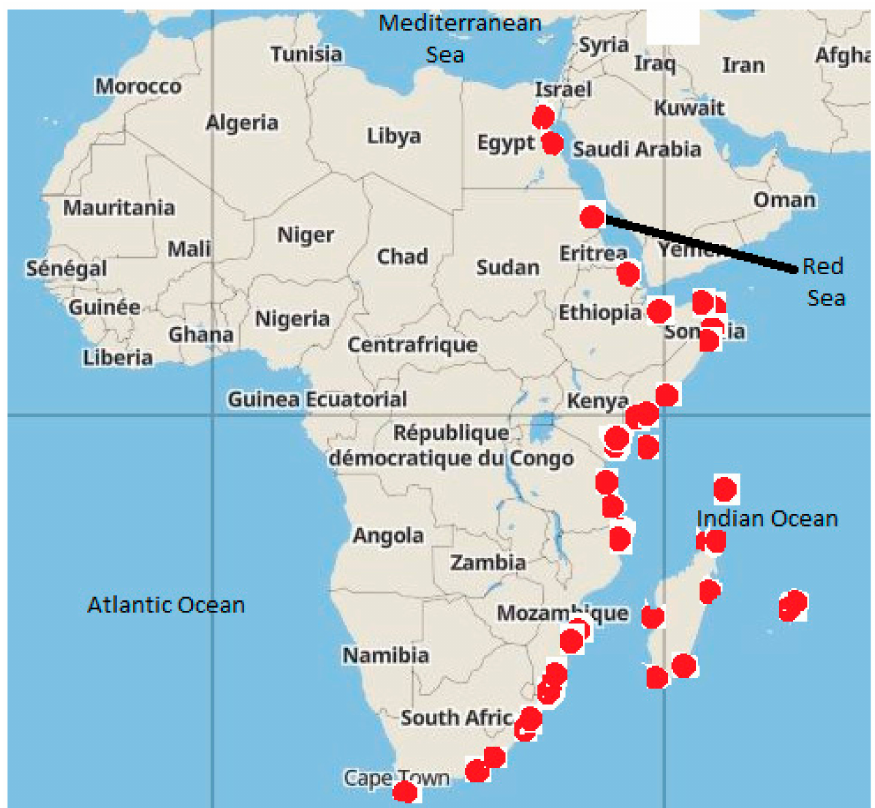
Figure 1. Locals (sites) of main sources of heavy metal in the African coasts of the Indian Ocean and the Red Sea. In these locales, there is port activity, tourism and petroleum